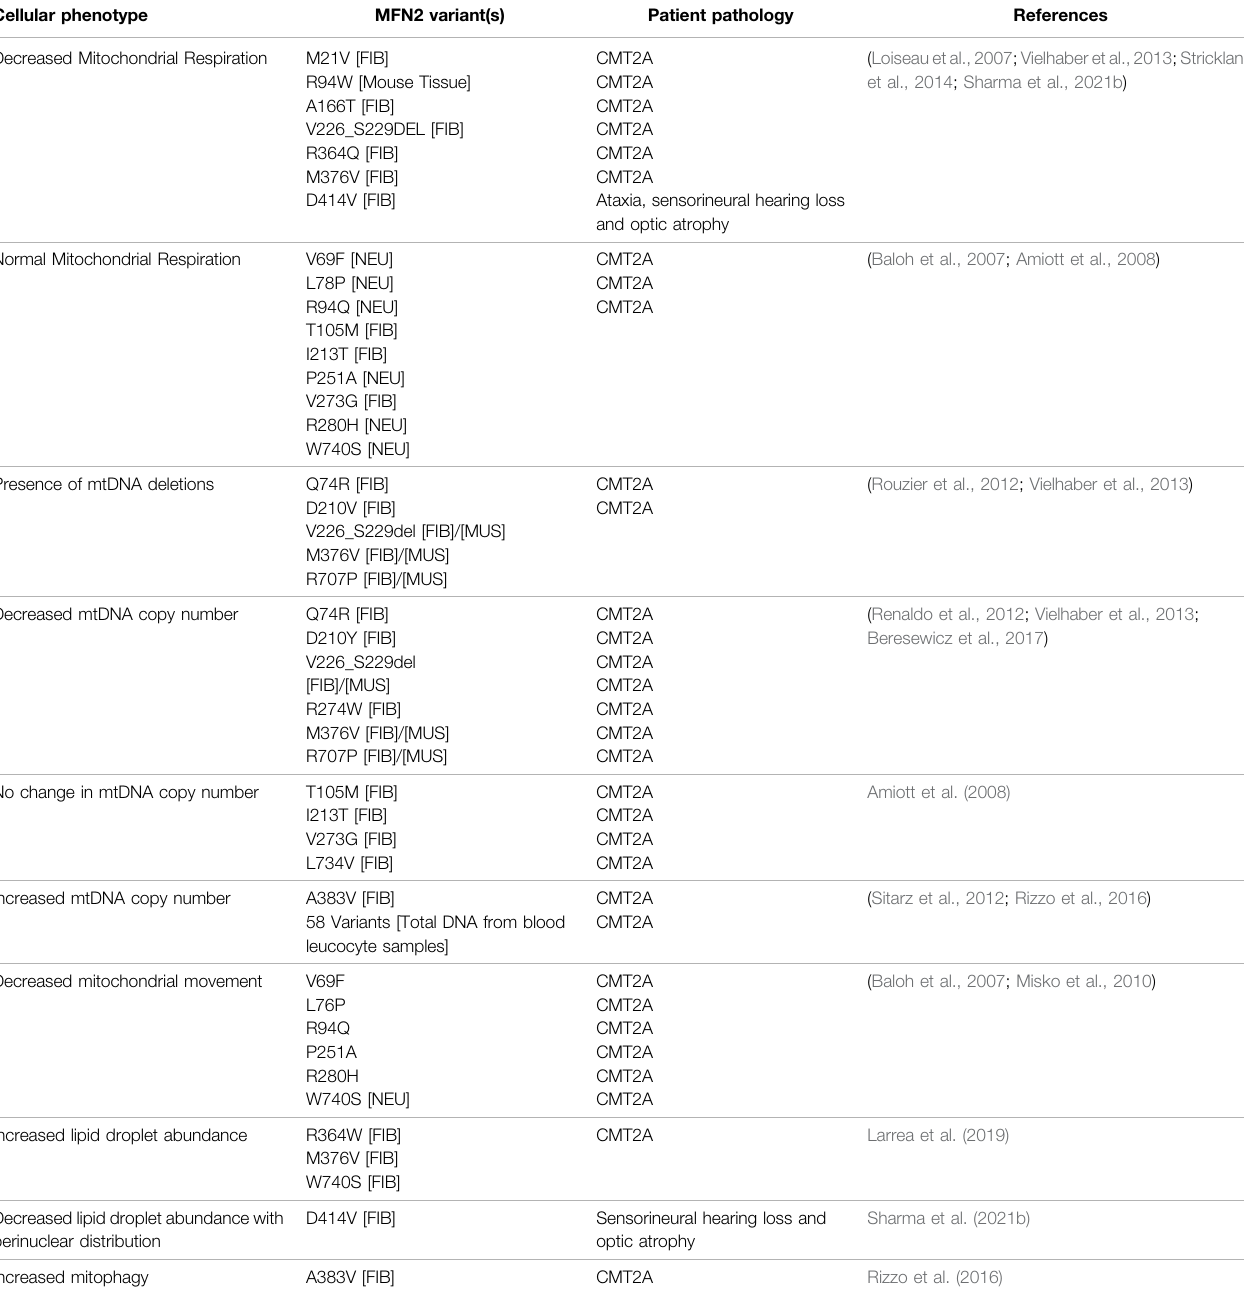
TABLE 2 | Pathogenic MFN2 variants with additional cellular alterations. In addition to alterations in mitochondrial morphology and MERCs ( Table 1 ), several other cellular phenotypes have been investigated for some MFN2 variants (e.g., mitochondrial respiration, mtDNA, and lipid droplets). The MFN2 variants and patient phenotypes described for these cellular phenotypes are indicated. Examples with no reported changes in cellular phenotypes are also included. Unless otherwise speci fi ed, the cell type or tissue investigated is indicated as follows: patient derived fi broblasts [FIB]; mouse embryonic fi broblasts with Mfn1/Mfn2 double KO and variant re-expressed [MEF]; skeletal muscle samples [MUS]; re-expression in rat neurons [NEU]. Relevant references are